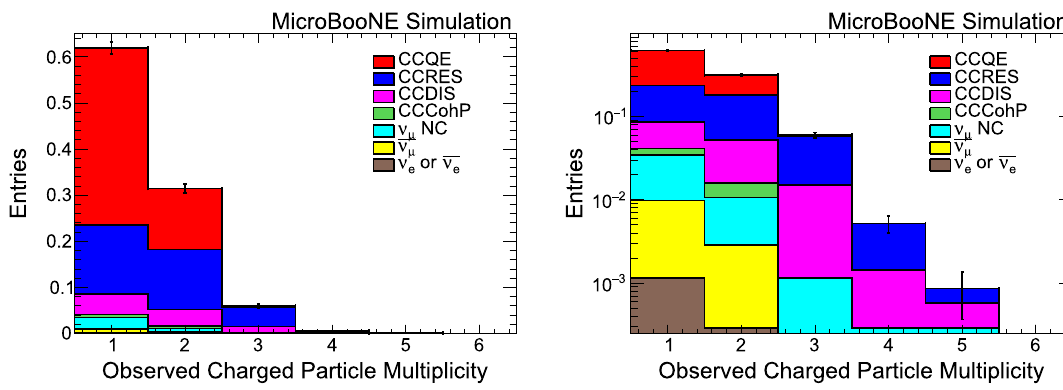
Fig. 28 Observed (stacked) multiplicity distributions for different neutrino interaction types from BNB-only default MC simulation in linear scale (left); and in log y scale (right). Black error bars represent MC statistical